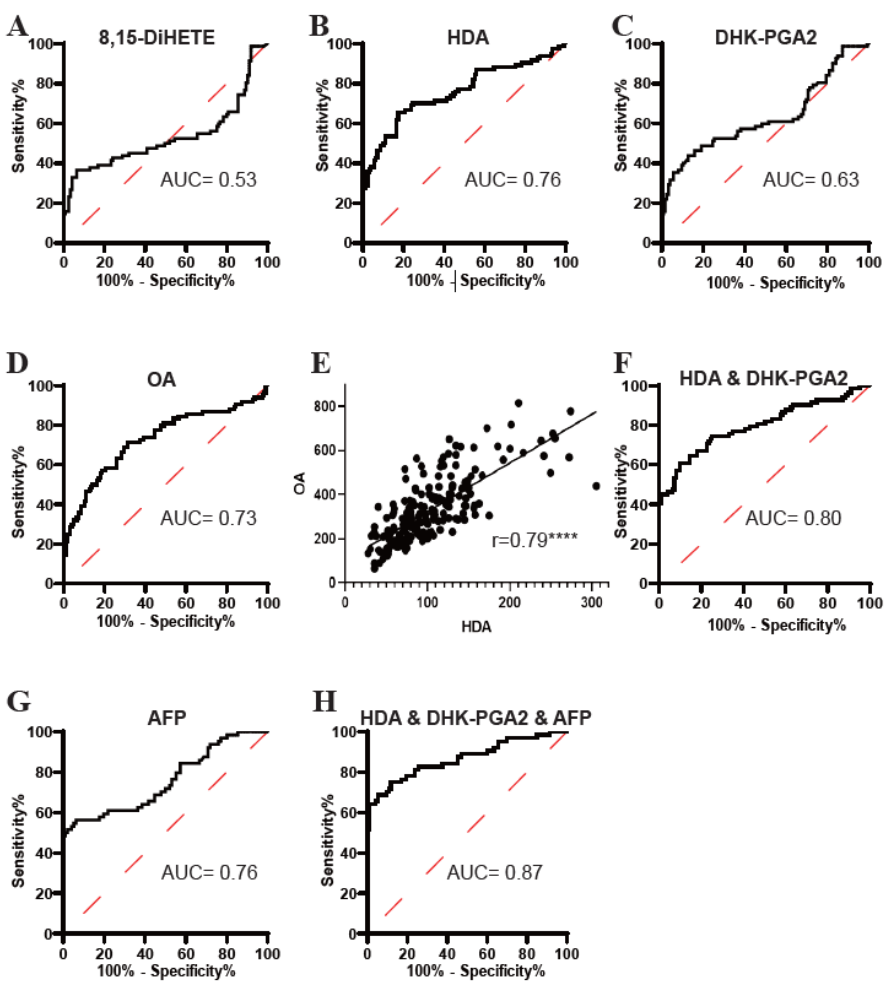
Figure 4. The diagnostic performance of 8,15-DiHETE, HDA, DHK-PGA2 and OA in the test set. ( A ) The ROC curve of 8,15-DiHETE for discriminating T2DM(+) HCC from T2DM patients. ( B ) The ROC curve of HDA for discriminating T2DM(+) HCC from T2DM patients. ( C ) The ROC curve of DHK-PGA2 for discriminating T2DM(+) HCC from T2DM patients. ( D ) The ROC curve of OA for discriminating T2DM(+) HCC from T2DM patients. ( E ) Linear correlation of HDA and OA levels in T2DM and T2DM(+) HCC patients in the test set. Spearman's correlation analysis was employed. **** p value < 0.0001. ( F ) The ROC curve of the combination of HDA and DHK-PGA2 for discriminating T2DM(+) HCC from T2DM patients. ( G ) The ROC curve of AFP for discriminating T2DM(+) HCC from T2DM patients. ( H ) The ROC curve of the biomarker signature based on HDA, DHK-PGA2 and AFP for discriminating T2DM(+) HCC from T2DM patients. AFP, alpha-fetoprotein; T2DM, type 2 diabetes mellitus; HCC, hepatocellular cancer; ROC, receiver operating characteristic; AUC, area under the ROC curve.